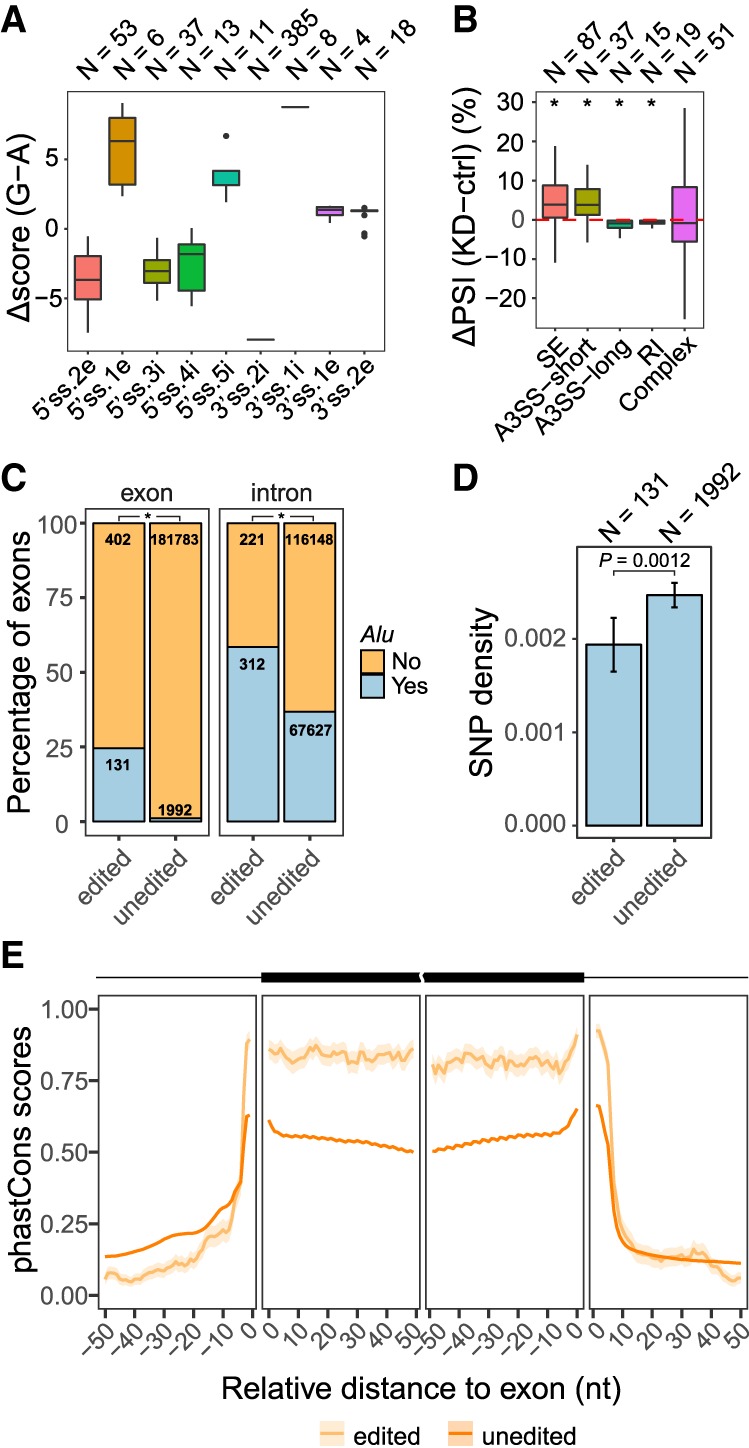
RNA editing sites located in splice site regions. (A) Box plot of the difference in splice site strength caused by A-to-I editing. Splice site scores were calculated using the maxEnt method (Yeo and Burge 2004): (5′ss) 5′ splice site; (3′ss) 3′ splice site; (i) intron; (e) exon; (N) number of editing sites. The number before i or e represents the distance (in nucleotides) from the exon–intron boundaries. Nucleotide positions without any editing sites in our data were excluded from this plot. (B) Box plot of PSI changes (ΔPSI) upon ADAR1 KD in U87MG cells measured via RNA-seq for exons with editing sites at the −2 intronic position of 3′ss (3′ss.2i), altering the canonical 3′ acceptor site from AG to GG: (SE) skipped exons; (A3SS-short) alternative 3′ss generating shorter exons given the edited G in the 3′ss; (A3SS-long) alternative 3′ss generating longer exons given the edited G in the 3′ss; (RI) retained introns; (Complex) complex splicing patterns; (N) number of exons; (*) P < 0.05 for ΔPSI ≠ 0 (Wilcoxon rank-sum test). (C) Percentage of exons or their upstream introns that overlap Alu repeats: (edited) exons or introns with editing sites in the 3′ss AG sequence; (unedited) all internal exons or introns without editing sites in the 3′ss. The number of exons or introns in each category is shown. The edited groups are significantly more enriched with Alus than unedited groups for both panels. (*) P < 2.2 × 10−16 (Fisher's exact test). (D) Density of SNPs (common SNPs in dbSNP version 150) in Alu-overlapping exons as described in C. Error bars represent standard errors. Edited exons have smaller SNP density than unedited ones (P = 0.0012, Wilcoxon rank-sum test). (E) Average phastCons scores of non-Alu-overlapping skipped exons (described in C) and their flanking intronic regions. Exon–intron boundaries are positioned at 0. The shaded area represents standard errors.